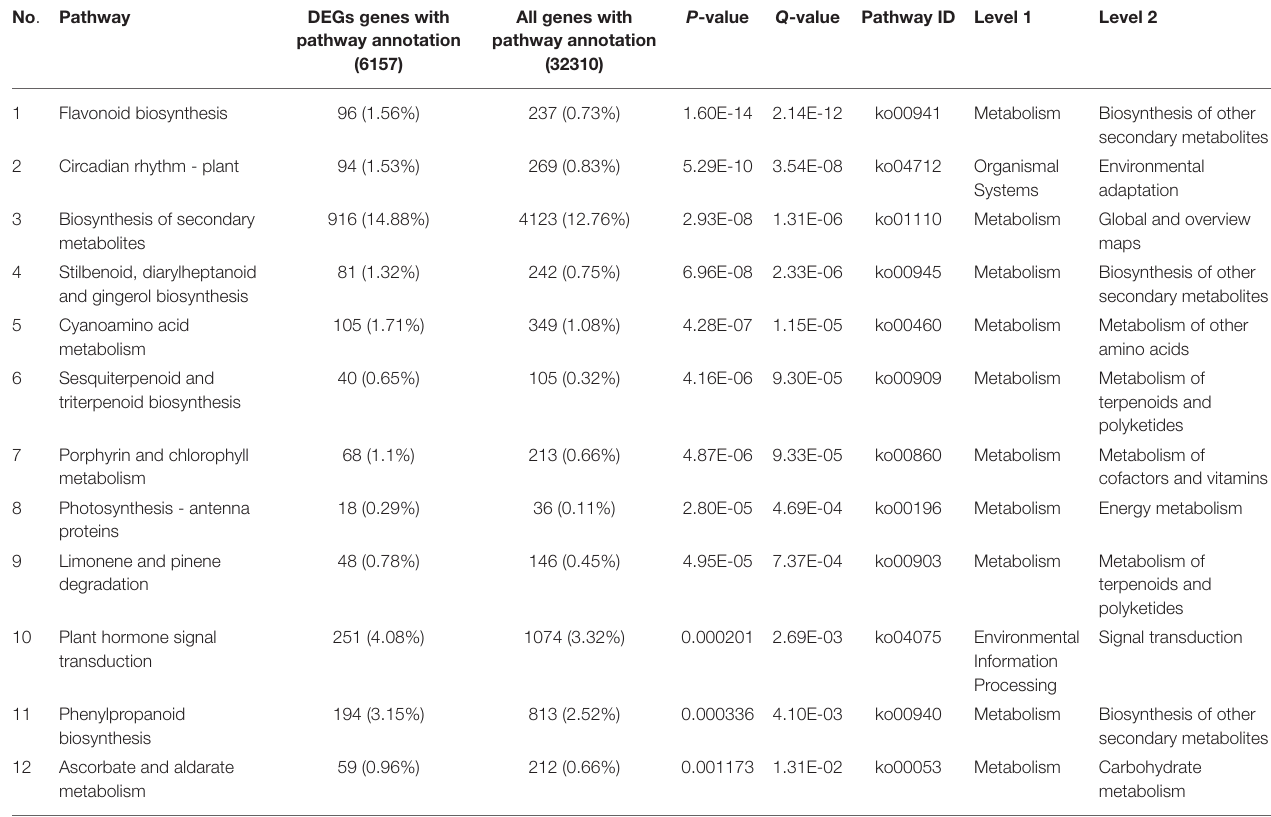
TABLE 4 | Significant enriched pathways in SAP1-VS-SAP2 paired comparison of Rubus.